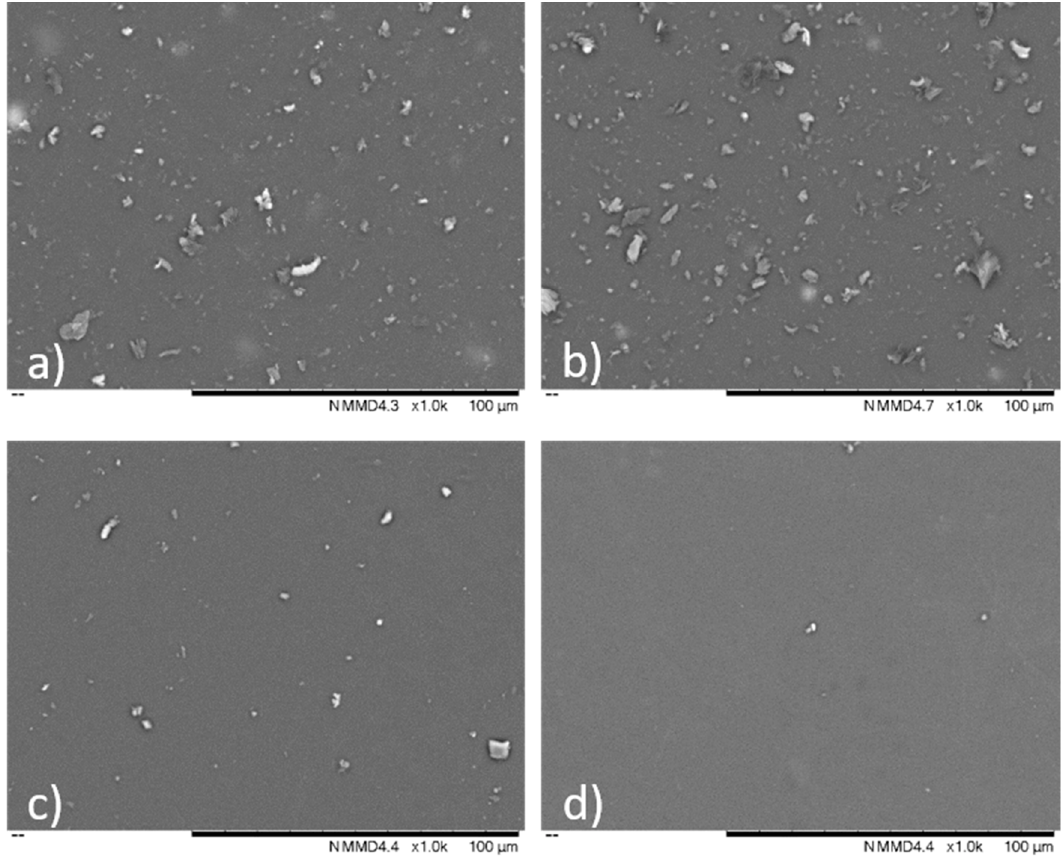
Figure 4. Typical SEM images of surface topography of coatings obtained in different gas atmospheres: ( a ) Ar, ( b )Ar/Ne, ( c ) Ar/C 2 H 2 , ( d ) Ar/Ne/C 2 H 2 .